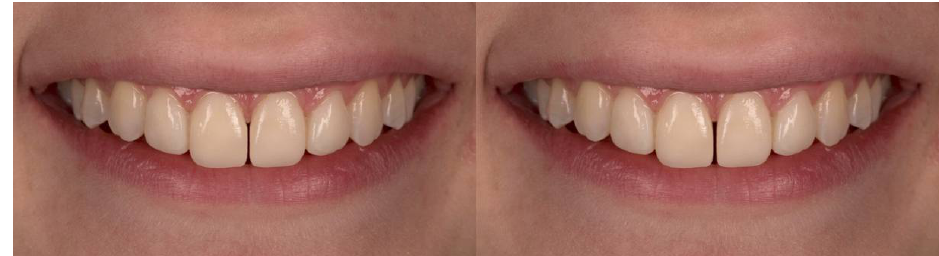
Figure 4. Midline diastema of 0.5 and 1 mm.